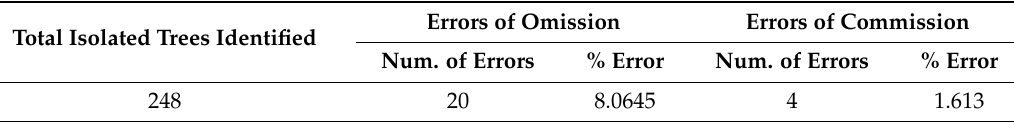
Table 6. Results of the evaluation in the classification of isolated trees.